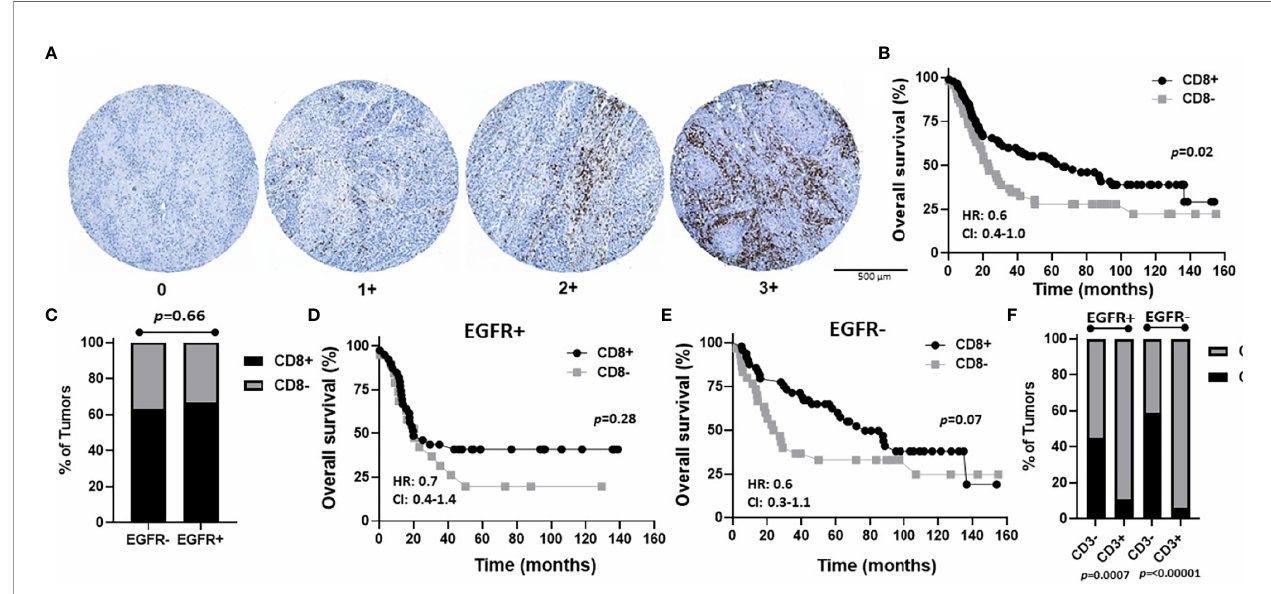
FIGURE 7 | Prognostic impact of combined EGFR and CD8 expression in OSCCs. (A) Shown are images of no [0], low [1+], moderate [2+], and strong [3+] CD8 expression scores. (B) Kaplan-Meier estimates of the overall survival of CD8+ (2+, 3+, 1+) and CD8- (0) patients. (C) Percentages of tumors with CD8+ and CD8- expression based on EGFR status. (D, E) Kaplan-Meier estimates of overall survival of CD8+ and CD8- patients based on EGFR+ (D) or EGFR- (E) tumor expression. (F) Percentages of tumors with CD8+ and CD8- expression based on EGFR and CD3 status. HR, hazard ratio; CI, 95% con fi dence